Question: Express in one sentence what the figure is showing.
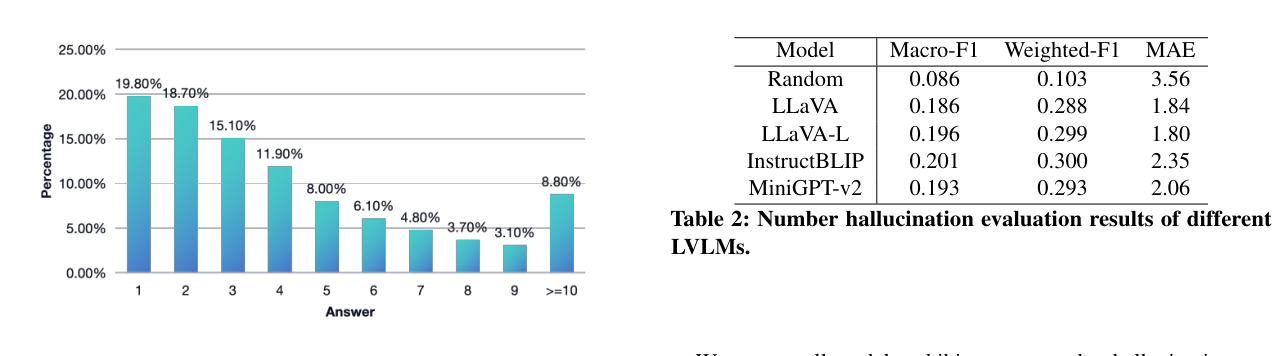
Answer: The distribution of the answers to the questions.